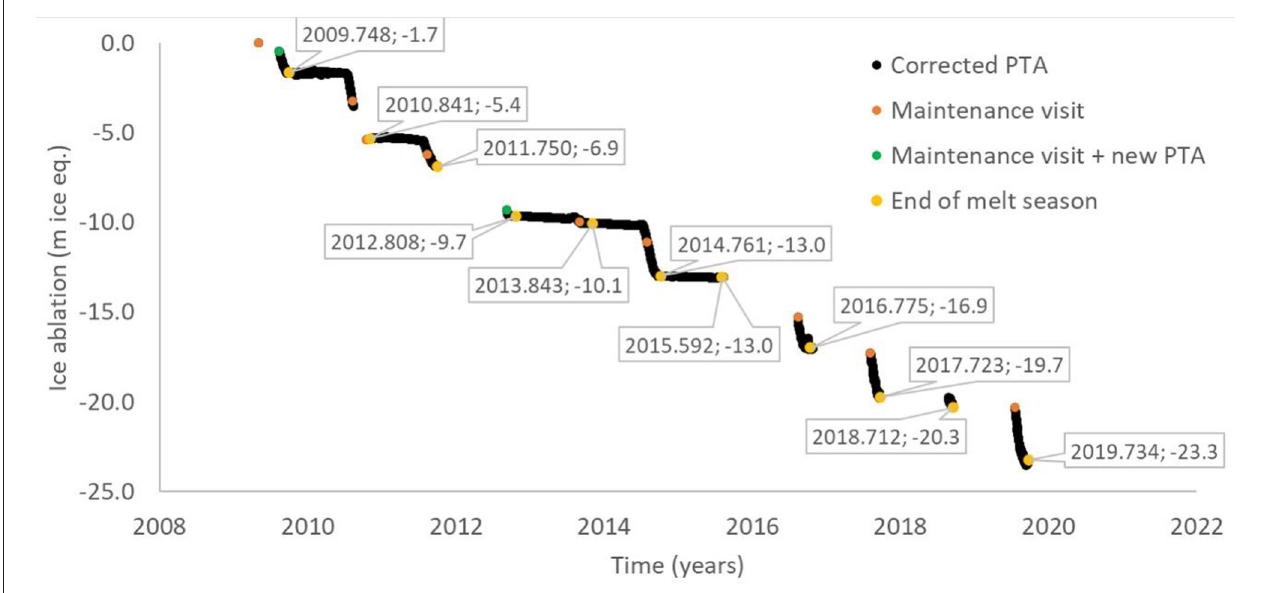
FIGURE 2 | Corrected pressure transducer assembly (PTA) readings following Fausto et al. (2012a). PTA readings were vertically shifted for new PTAs drilled into the ice in order to align the data into a continuous cumulative ice ablation record.